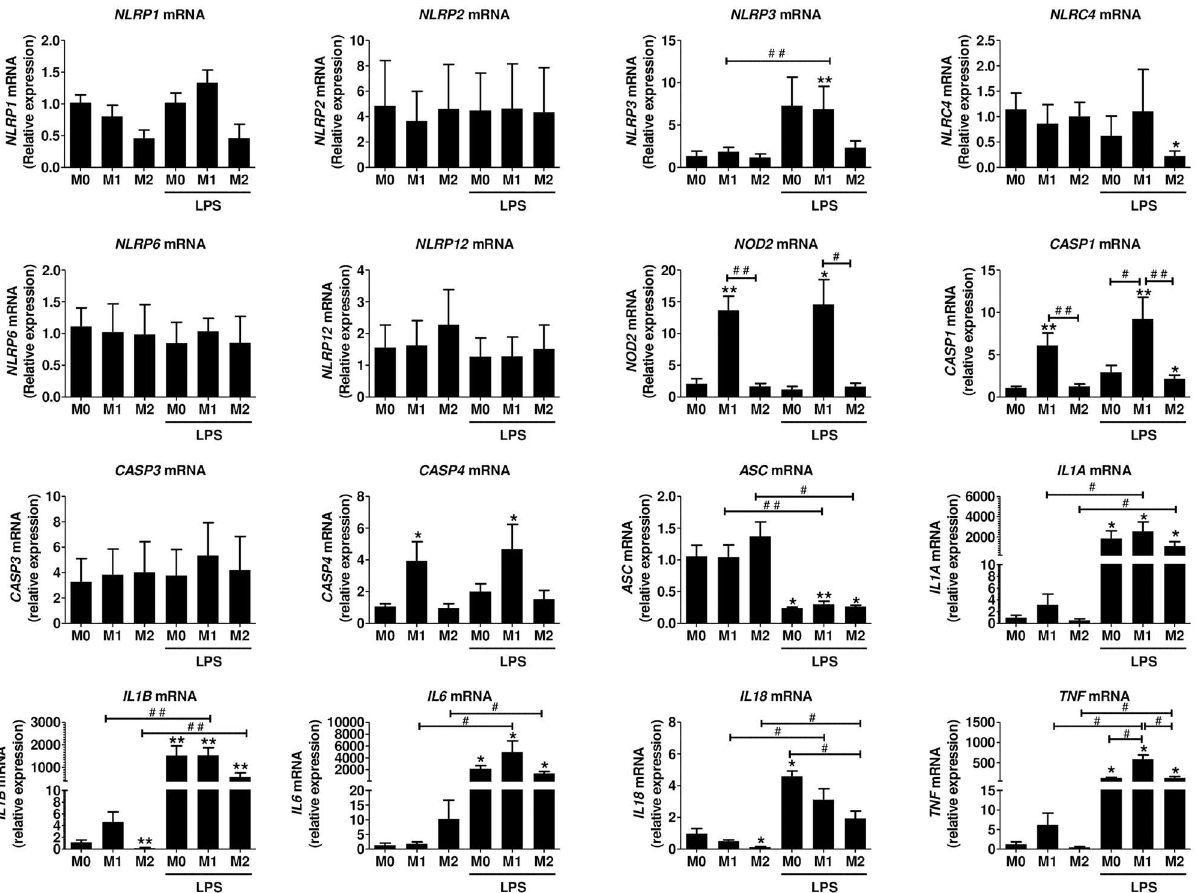
Fig 3. NLR, CASP and cytokine gene expression in human polarized monocytes. Monocyteswere polarizedtowards M1 or M2 and stimulatedwith 100 ng/ml LPS for 3h as describedin the methods. mRNA was isolatedand gene expressionwas measuredby RT-qPCR and expressedas relativefold change of M0. Data represent the mean ± SEM of (cid:21) 4 experiments performed in duplicates in cells isolated from (cid:21) 4 independentdonors. M0: cells treated with completemedium (control); M1: cells treated with 100 ng/ml IFN- γ (polarizedtowards M1); M2: cells treated with 10 ng/ml IL-4+IL-13 (polarizedtowards M2). Asterisks indicate significantdifferences as comparedto M0 (Mann Whitney test: * p < 0.05; ** p < 0.01); (#) points out significantdifferencesbetween the indicatedgroups(Mann Whitney test: # p < 0.05; ## p <